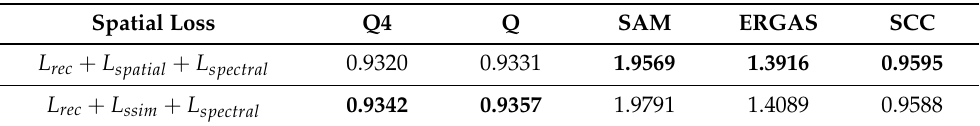
Table 7. The quantitative comparison between the spatial loss and structure similarity loss. The Best Results are Shown in Bold